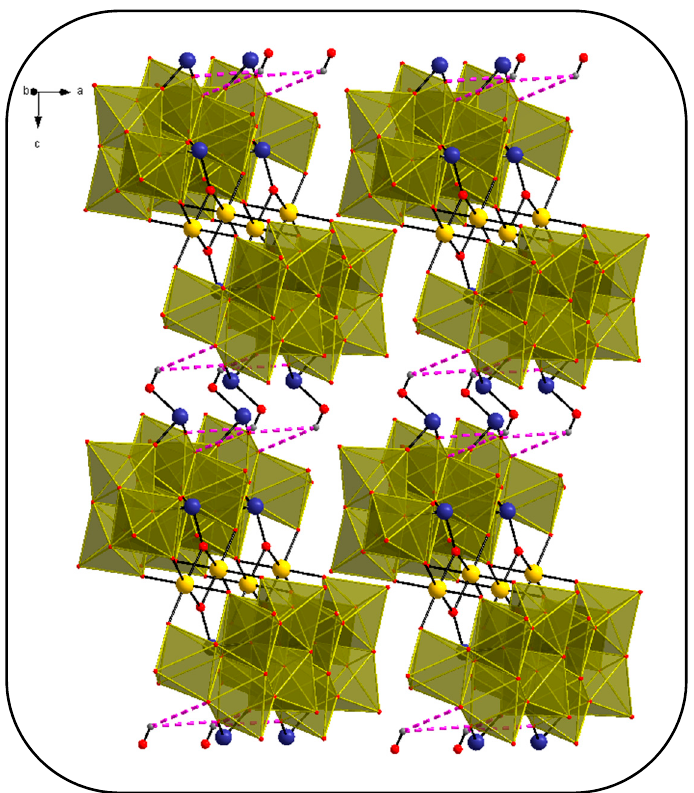
Figure 3. The packing arrangements in 1 . Hydrogen bonds are drawn as pink dashed lines. Color code: WO 6 octahedra olive green, As blue, Fe yellow, O red, H gray.